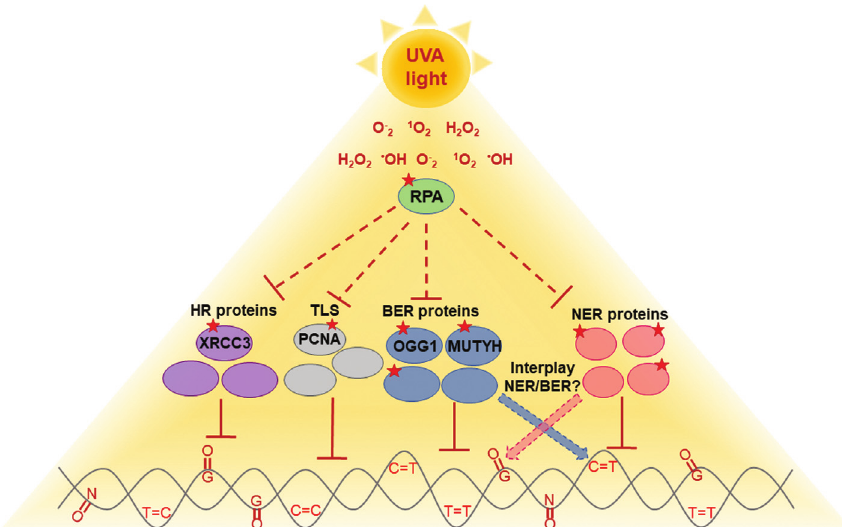
Figure 2 - UVA light induces mixture of photoproducts and oxidized base damage in the DNA, as well as, ROS production. As result of UVA-induced ROS production, protein oxidation has been gaining attention because it can also damage DNA repair proteins, which acts on both NER and BER. Thus, UVA irradiation causes decreased repair capacity of target lesions of both pathways, which may be the result of RPA oxidation, or the oxidation of other NER and BER proteins. RPA impairment may further compromise other DNA repair or tolerance pathways, such as homologous recombination (HR) and translesion synthesis (TLS). Red stars represent proteins known to be target of oxidative